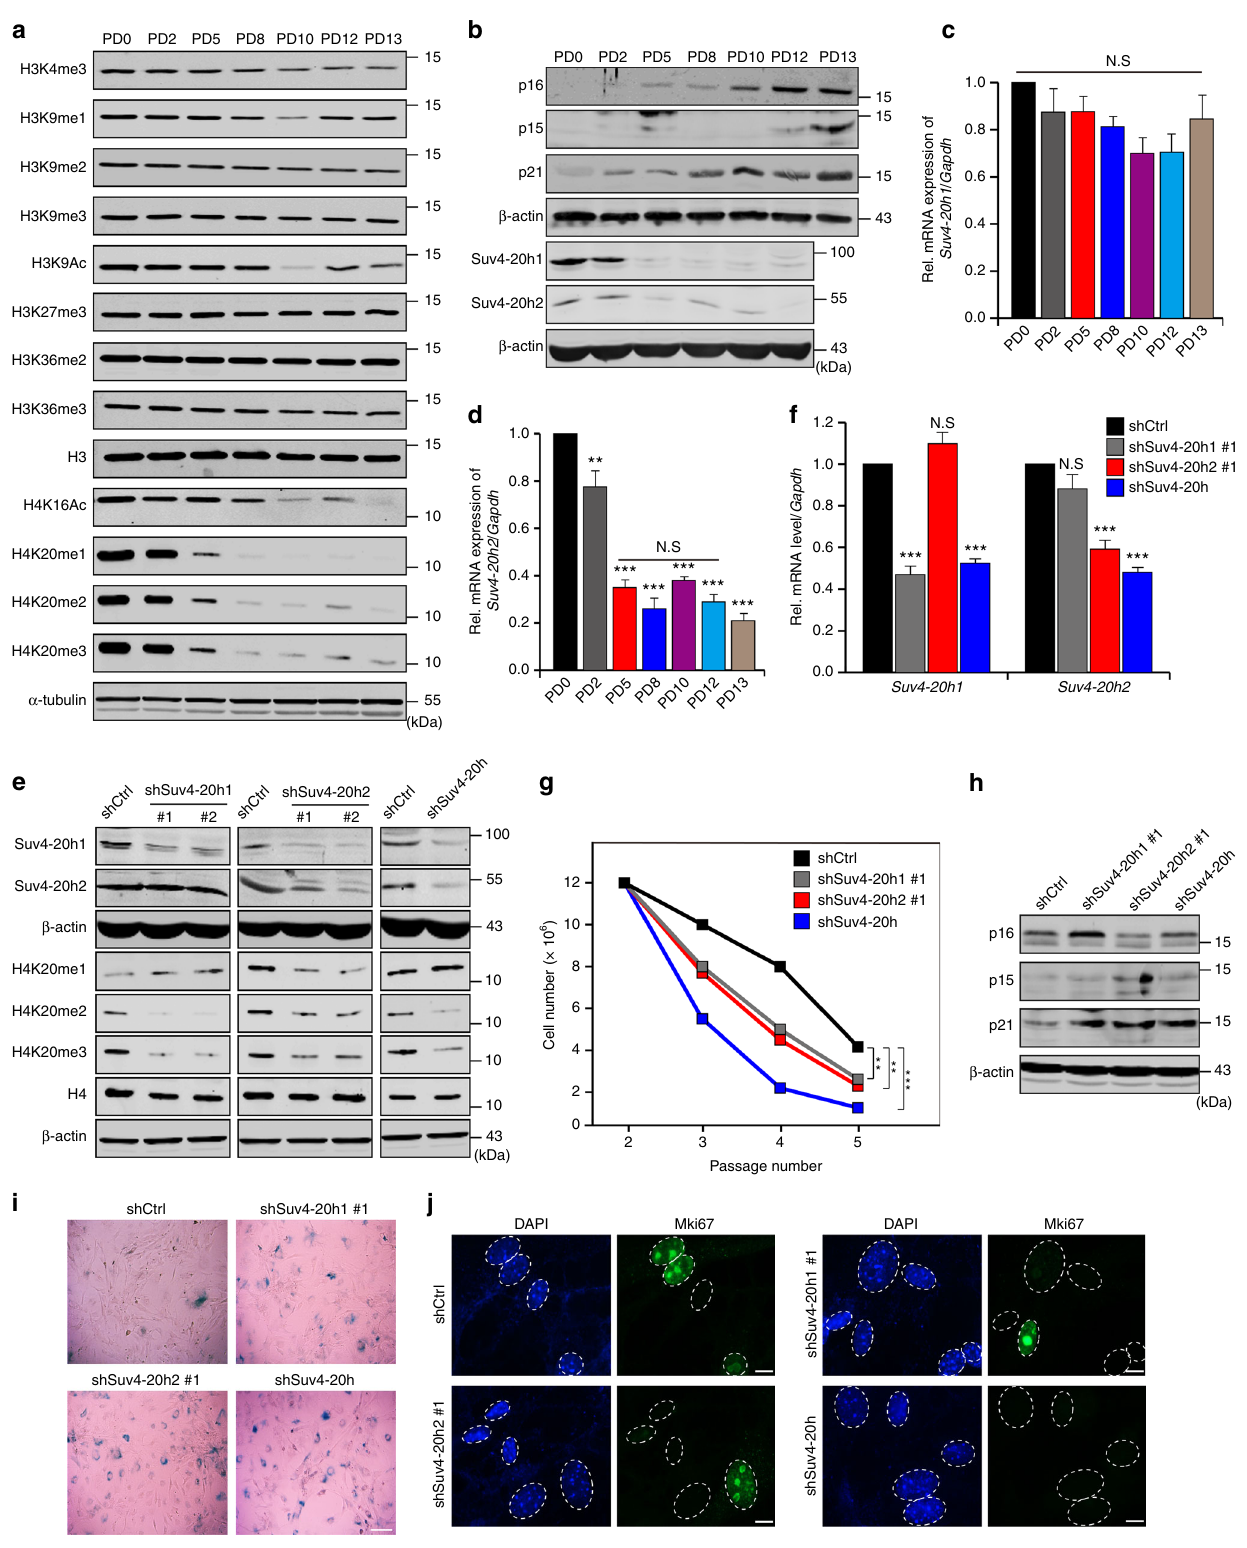
Fig. 1 Loss of H4K20me3 promotes cellular senescence. a Western blot for total protein of the indicated histone modi fi cations from serially passaged MEFs. H3, H4 and α -tubulin served as loading controls. b Western blots showing expression of p16, p15, p21, Suv4-20h1 and Suv4-20h2 during MEFs senescence. β -actin served as a loading control. c , d Real-time qPCR analysis of Suv4-20h1 ( c ) and Suv4-20h2 ( d ) mRNA expression in different passages of MEFs. e , f Western blot ( e ) and RT-qPCR ( f ) for Suv4-20h in knockdown cells. g Growth curve of Suv4-20h-depleted cells. h Expression of p16, p15 and p21 in Suv4-20h knockdown cells. β -actin served as a loading control. i SA- β -gal staining in control (Ctrl) and Suv4-20h (shSuv4-20h) knockdown cells. Scale bar, 20 μ m. j Immuno fl uorescent staining of Mki67 in control (Ctrl) and Suv4-20h depleted cells. Scale bar, 5 μ m. Two-tailed unpaired Student t -tests were performed, ** p < 0.01, *** p < 0.001 NATURE COMMUNICATIONS| (2018) 9:2560 |DOI: